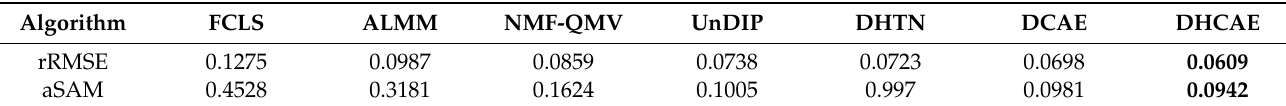
Table 5. Quantitative performance on the urban dataset containing noisy bands by various ap- proaches. The best result is shown in bold.